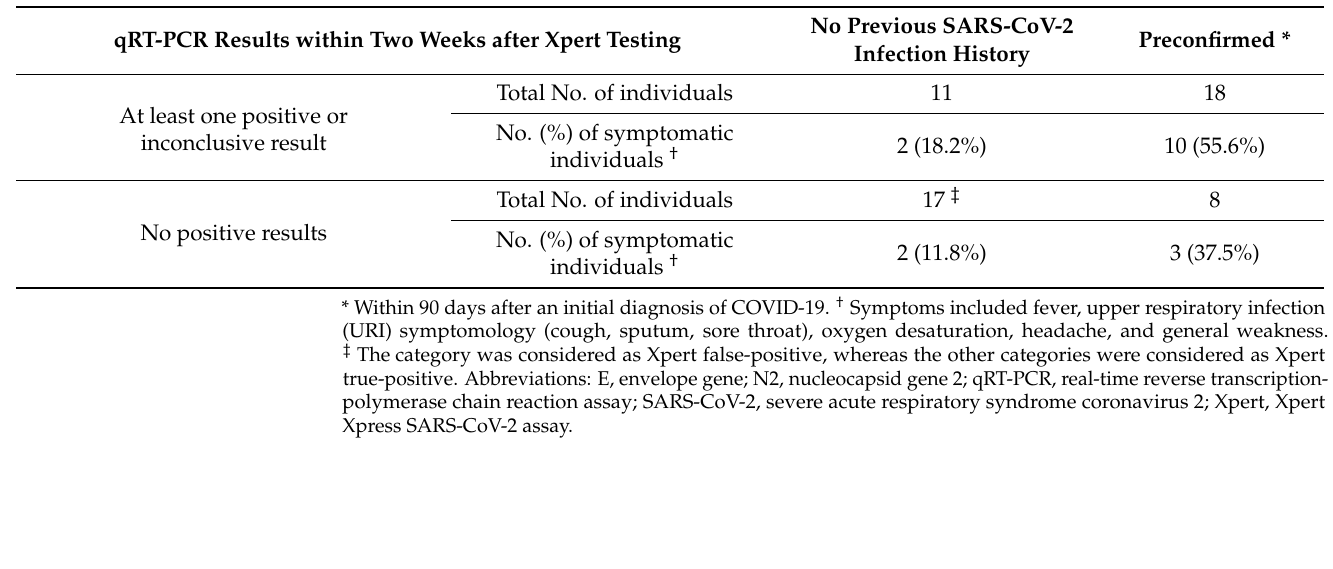
Table 3. Percentage of symptomatic individuals with E-gene-negative and N2-gene-positive Xpert